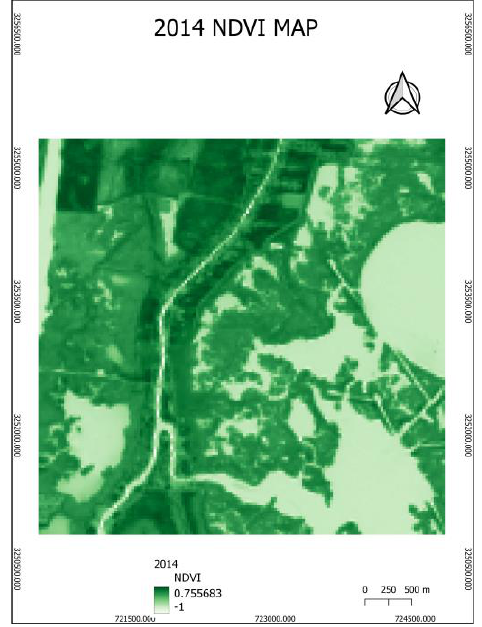
Fig.5 A 2014 map indicating the areas that were covered by vegetation at the time